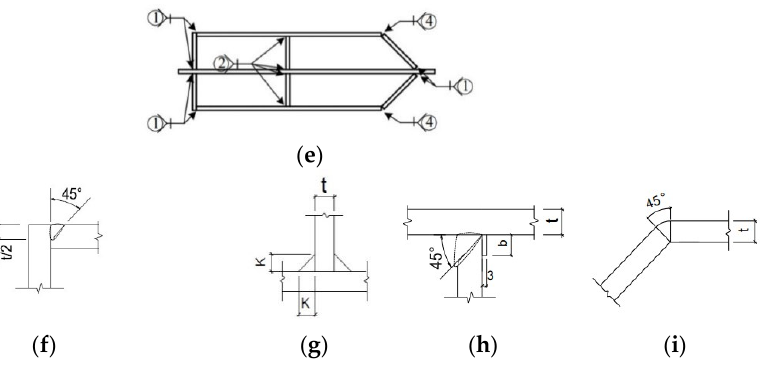
Figure 2. Weld locations and details. ( a ) PEN1 and PEN3; ( b ) PEN2; ( c ) PEN4; ( d ) PEN5; ( e ) PEN6; ( f ) Weld detail 1; ( g ) Weld detail 2; ( h ) Weld detail 3; ( i ) Weld detail 4.